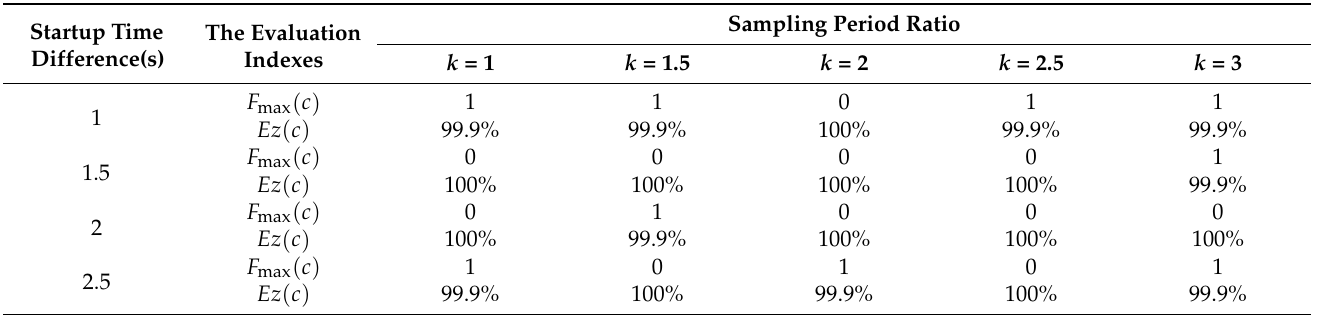
Table 4. The change of the false association times F max ( c ) and the average correct association rate Ez ( c ) with different k values and startup time difference.